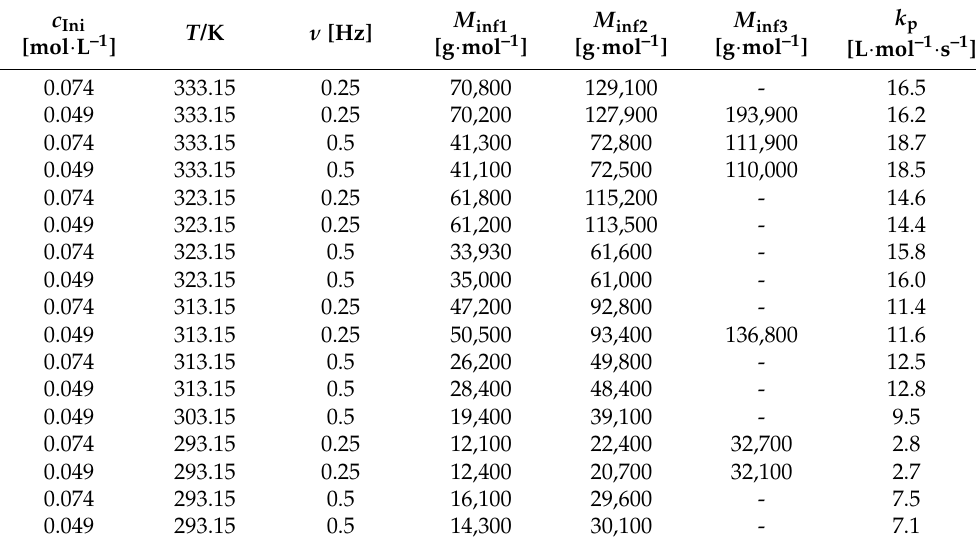
Table 4. PLP data for DnPI: initiator concentration, c Ini , temperature T , total number of pulses, n pulses , laser pulse frequency, ν , molecular weight at the various inflection points, M inf , and the average k p of all obtained inflection points.